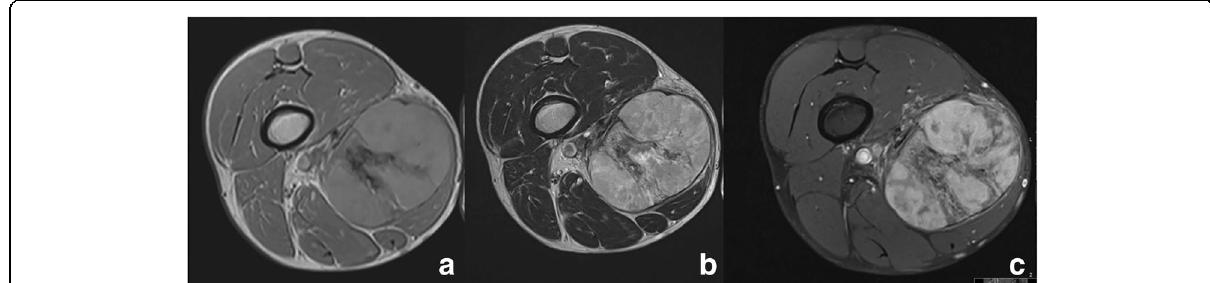
Fig. 11 Axial T1-weighted ( a ) T2-weighted ( b ) and contrast- enhanced MR images show a welldefined, enhancing soft-tissue mass in the medial compartment of the right thigh. Feeding vessels have low signal intensity in all sequences due to flow void